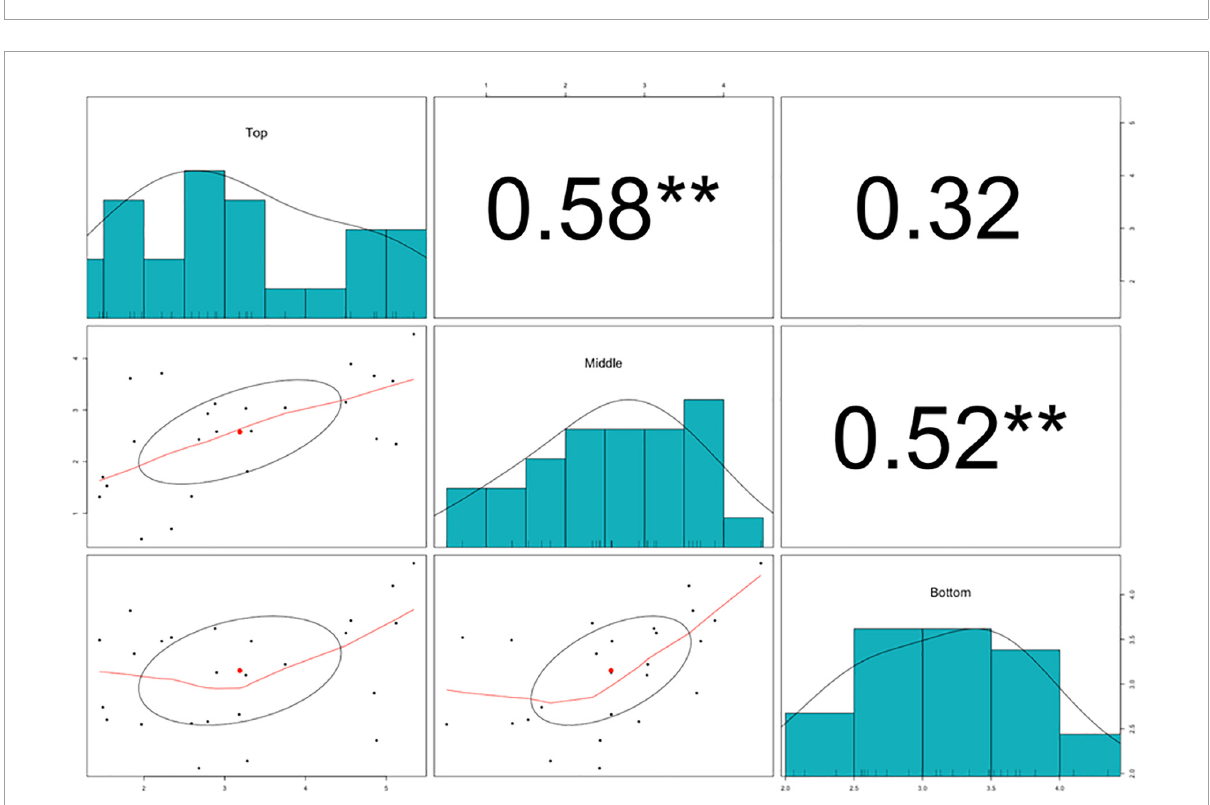
FIGURE7 Pearson’s correlation analysis, scatter plots, and density histograms on the splitting strength of the bottom, middle, and top part of the bamboo culm. Significant correlations are denoted with asterisks at significance level ** p < 0.01.